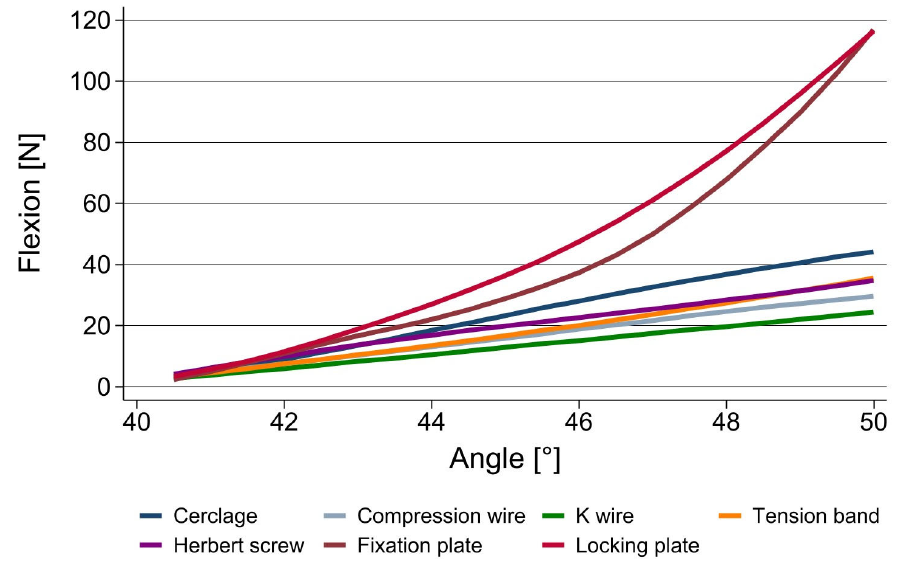
Figure 3. Stability of different fusion techniques for PIP joint arthrodeses in flexion.